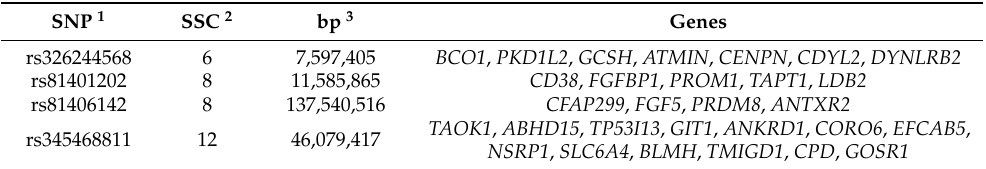
Table 5. SNPs at the center of each of the four genomic regions that explained > 2% of the additive genetic variance in at least one of the populations, and the genes located within 1 Mb downstream or